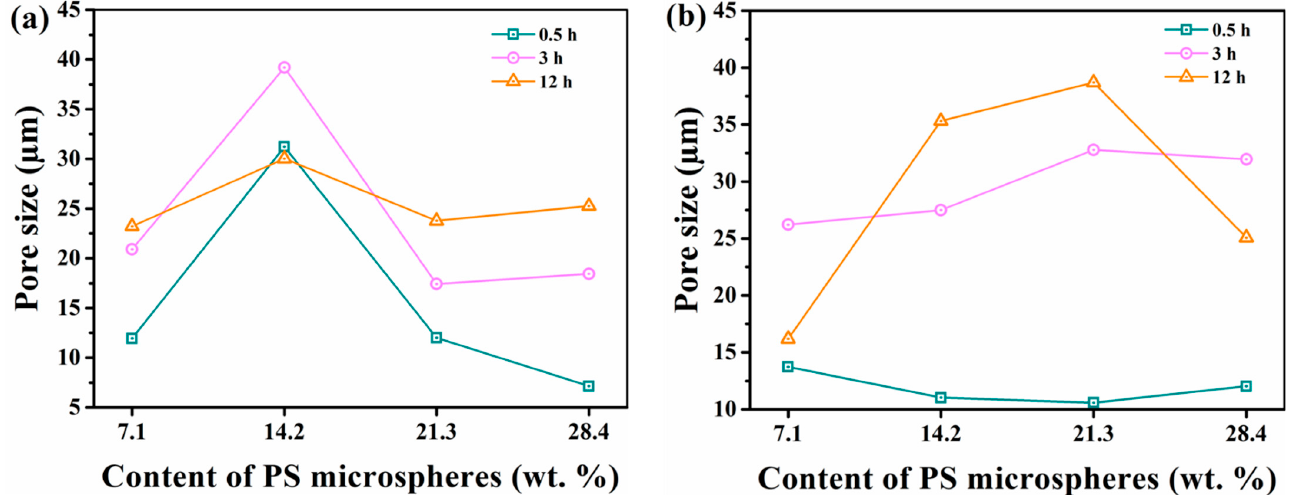
Figure 12. Effects of PS microspheres on pore size at different time: ( a ) Surface; ( b ) Fracture. The Dm of the fracture with different PS microsphere additions changed